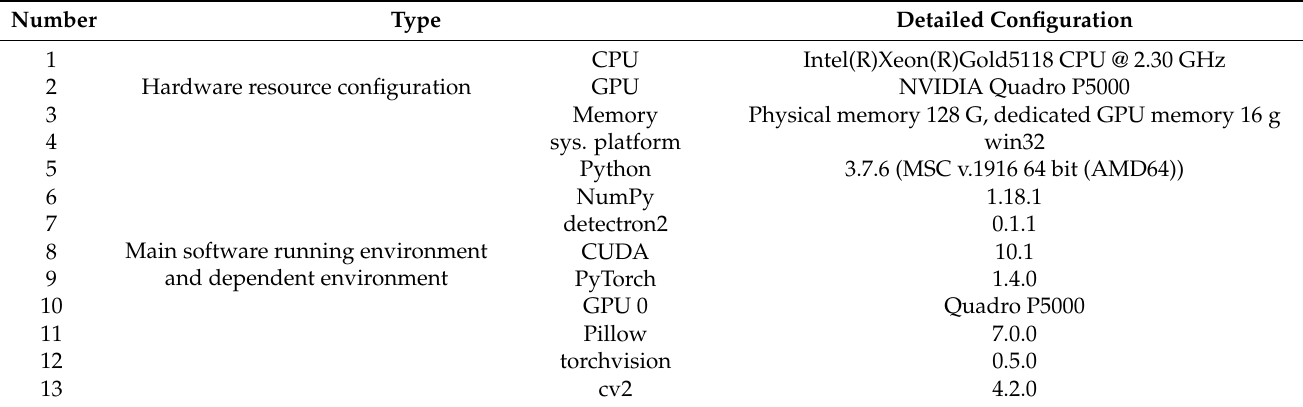
Table 1. Introduction to the experimental